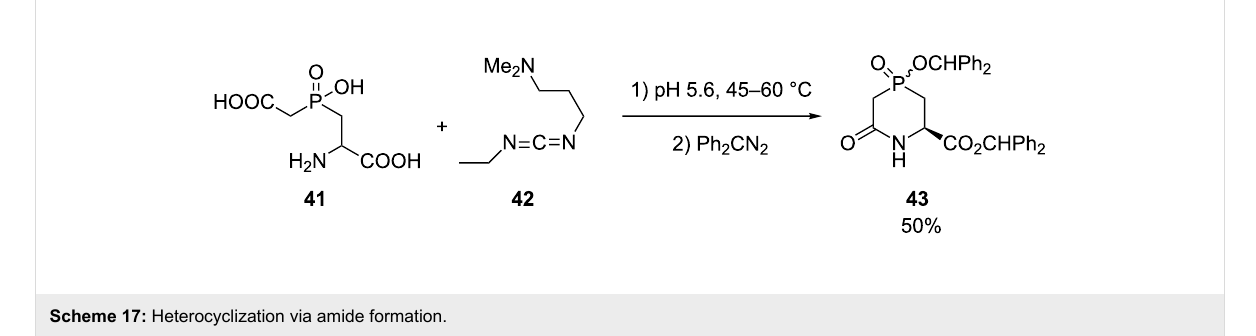
Scheme 17: Heterocyclization via amide formation.